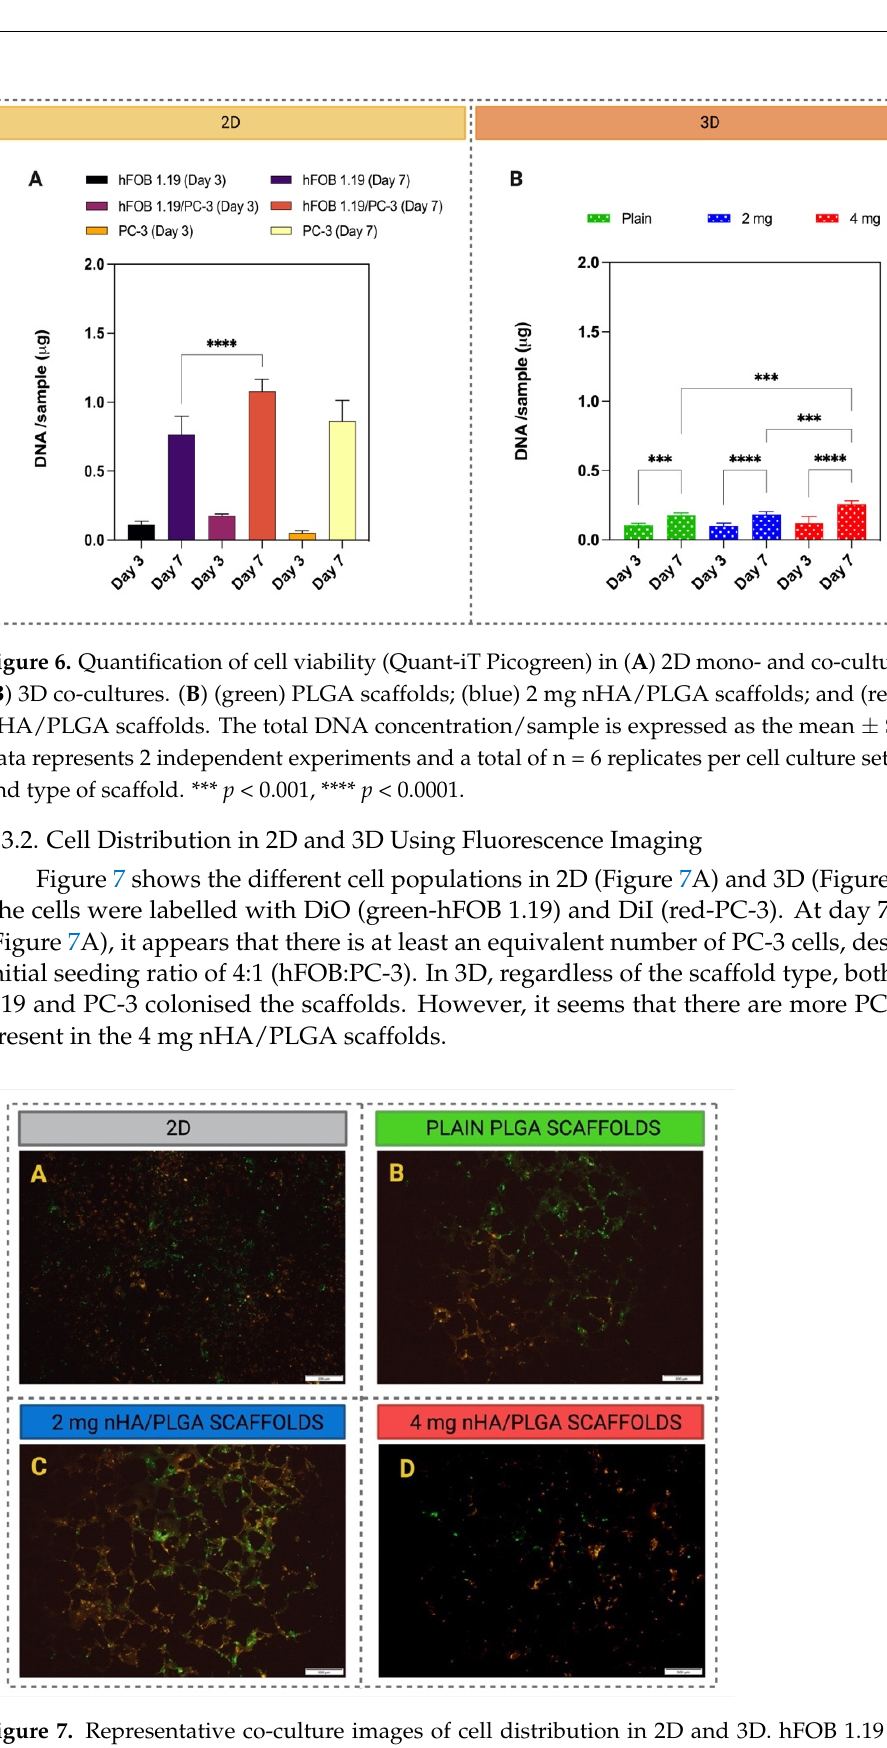
12 of 25 Figure 5. Degradation behaviour of cell-free scaffolds: (green) PLGA scaffolds, (blue) 2 mg nHA/PLGA scaffolds, and (red) 4 mg nHA/PLGA scaffolds. The degradation behaviour is expressed as the mean W D1–35 ± SD. The data are representative of n = 5 scaffolds per type at each time point. 3.3. Cell Behaviour in 2D and 3D 3.3.1. Cell Viability in 2D and 3D The preliminary co-culture studies investigated different ratios of hFOB 1.19: PC-3 cells (4:1 and 1:1) to create the model (Figure S3). The fluorescent images indicated that more osteoblasts were visible when cultured at a 4:1 ratio compared to a 1:1 ratio (Figure S3D). Hence, the 4:1 (hFOB 1.19: PC-3) ratio was selected for all further studies. Figure 6 displays the proliferative activity of mono and co-cultures in 2D (Figure 6A) and 3D co- culture (Figure 6B). The cell proliferation in mono- and co-culture in the 2D setup in- creased between days 3 and 7, Figure 6A. The same proliferative tendency was observed in 3D co-culture in all scaffolds, but the highest viability was observed in cells cultured in 4 mg nHA/PLGA scaffolds, with the quantity of DNA doubling from 0.121 μ g at day 3 to 0.256 μ g at day 7, Figure 6B. At day 3 there is no statistically significant difference in the amount of DNA quantified between the different scaffolds, but at day 7, the amount of free DNA quantified in the 4 mg nHA/PLGA was statistically greater than the other sam-